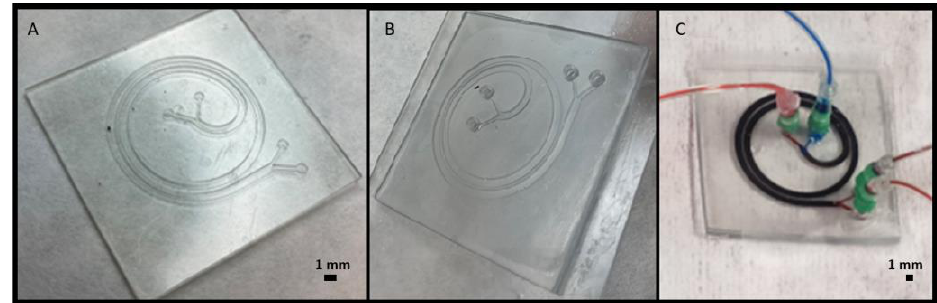
Figure 9. ( A ) 3D printed result with Detax resin of the embossed spiral, with a designed channel width of 1 mm and height of 600 µm. ( B ) Assembly of an open spiral and a cover printed separately, with Keyprint resin. ( C ) Microfluidic system consisting of two inputs and two outputs, used to separate particles by their size.